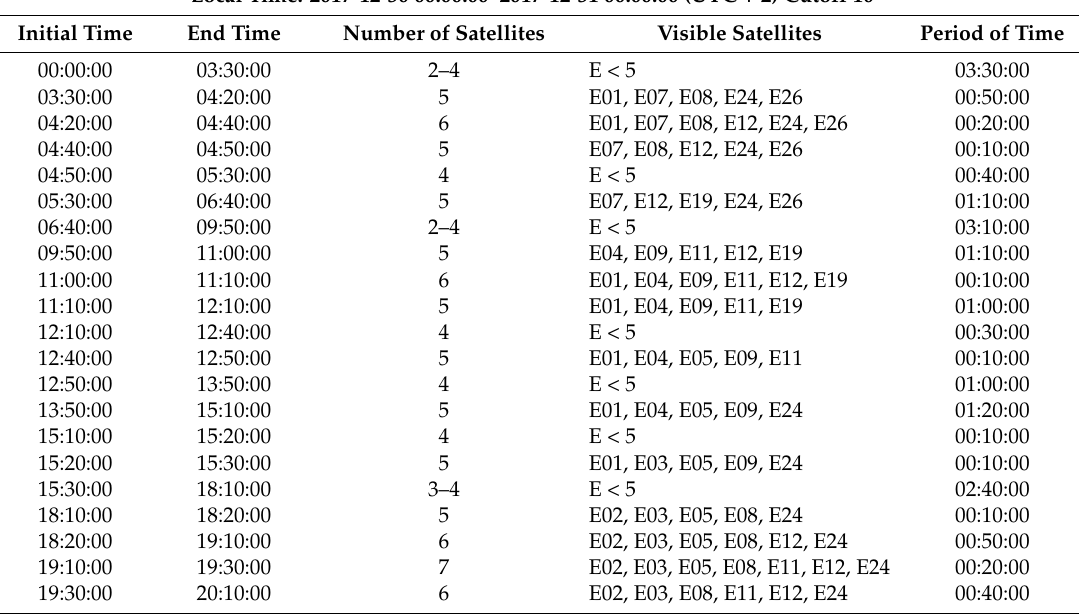
Table 3. Galileo satellites availability for the Day of Year: 364,